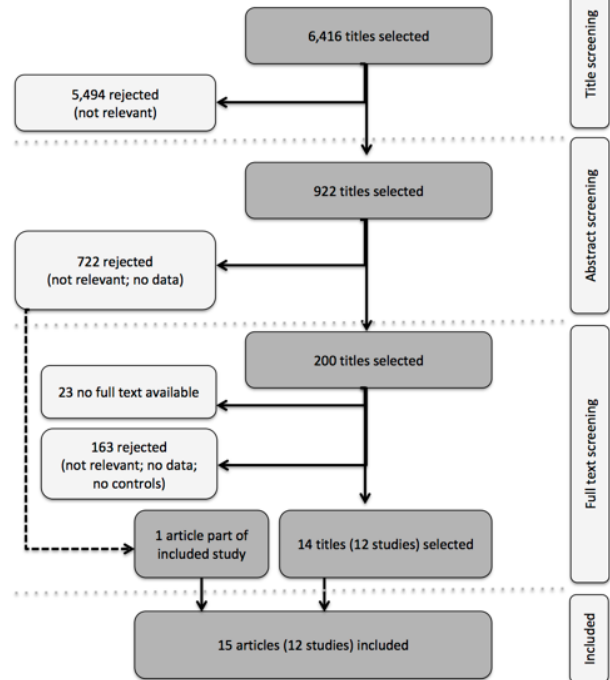
Figure 1. Flowchart showing process of screening and selection of studies for